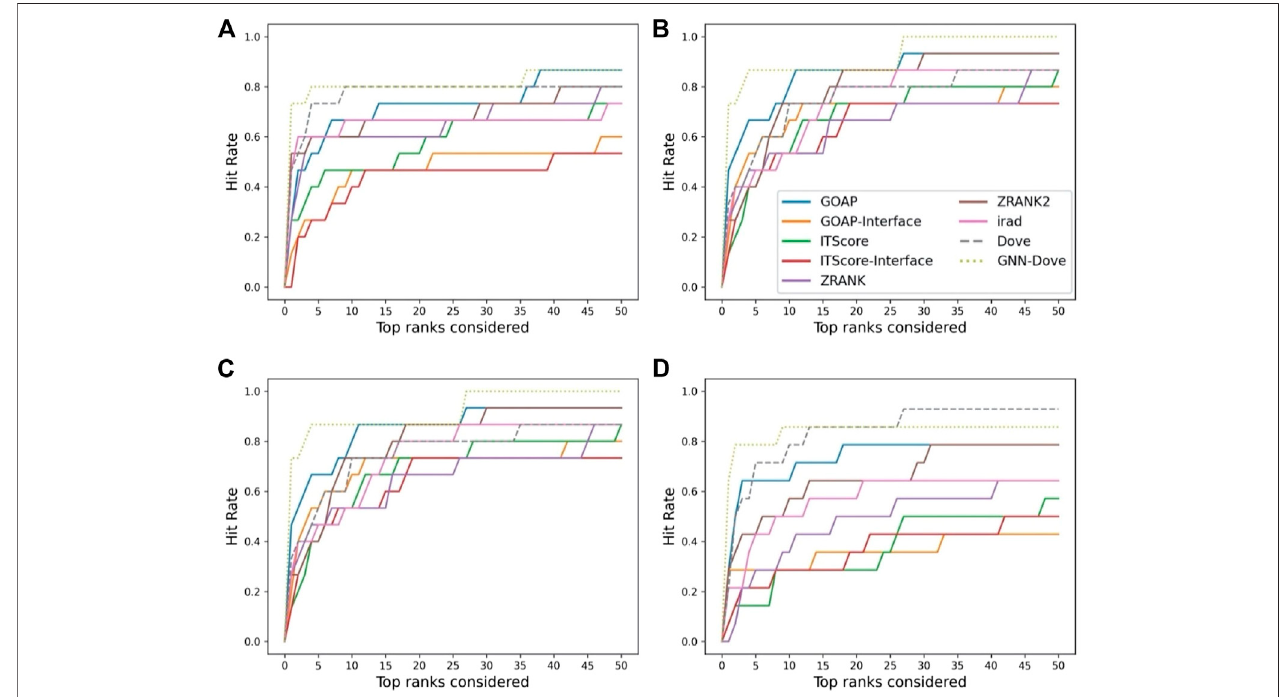
FIGURE3| ThehitrateisshownforeachfoldinthecrossvalidationontheDockgrounddataset.Proteincomplexesinthetestsetofeachfoldarelistedin Table1 . In the same way as Figure 2A , a hit rate was computed for individual complexes separately and averaged over the complexes. (A) The hit rate of the fold 1 test set. The model was trained on the fold 2, 3, and 4 subsets. (B) The fold 2 test set. (C) The fold 3 test set. (D) The fold 4 test